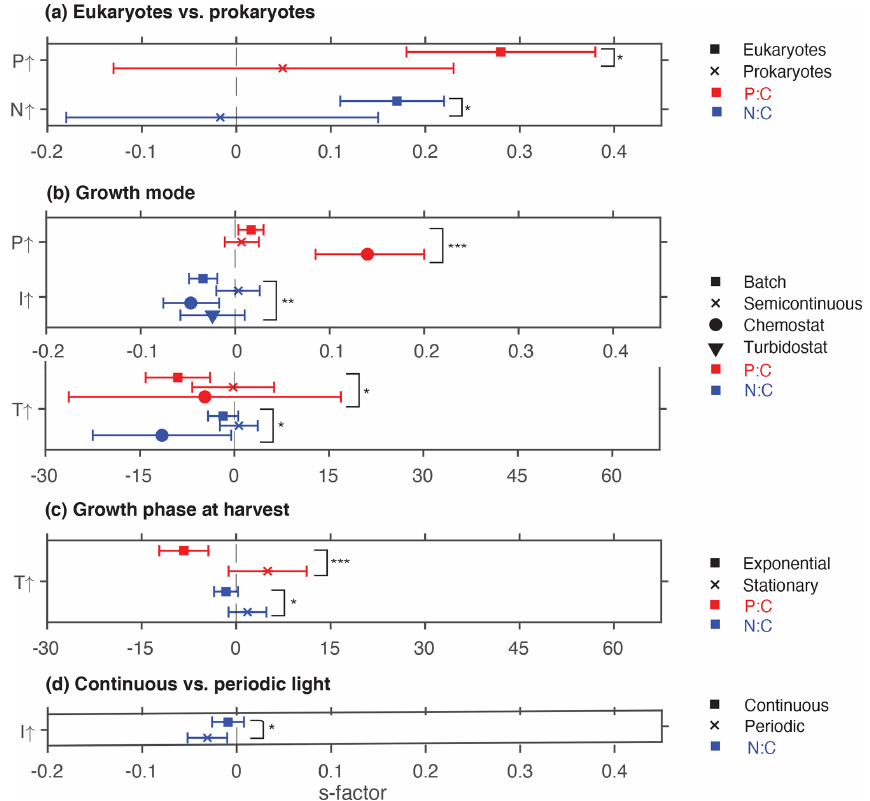
Figure 3. Summary plot showing statistically significant effects of moderators. (a) Eukaryotes vs. prokaryotes, (b) growth mode, (c) growth phase at harvest, and (d) light regime. ∗ P < 0 . 05; ∗∗ P < 0 . 01; ∗∗∗ P < 0 . 001; ns, not